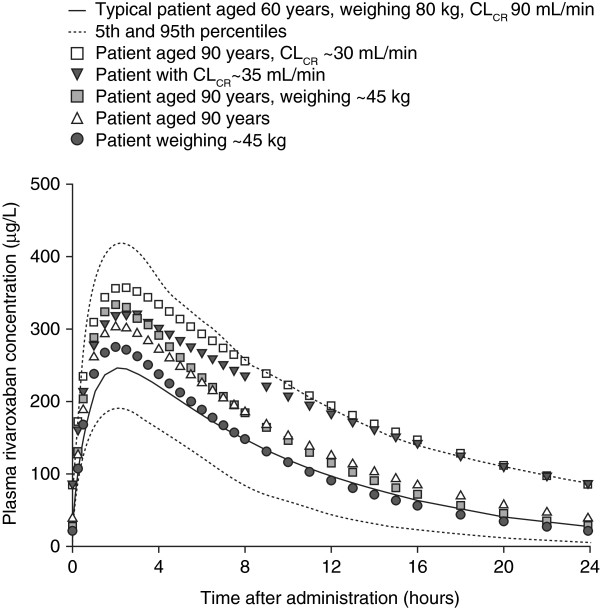
Predicted plasma rivaroxaban concentration–time profiles for extremes in age, renal function and body weight. Patients receiving rivaroxaban 20 mg once daily. The simulated patients had typical mean characteristics (age 60 years, body weight 80 kg, CrCl 90 ml/min) unless specified otherwise [12]. CLCR/CrCl, creatinine clearance. Reproduced from Mueck W, Lensing AW, Agnelli G et al. Rivaroxaban: population pharmacokinetic analyses in patients treated for acute deep-vein thrombosis and exposure simulations in patients with atrial fibrillation treated for stroke prevention. Clin Pharmacokinet 2011; 50:675–686 with permission from Adis (© Springer International Publishing AG 2011. All rights reserved).